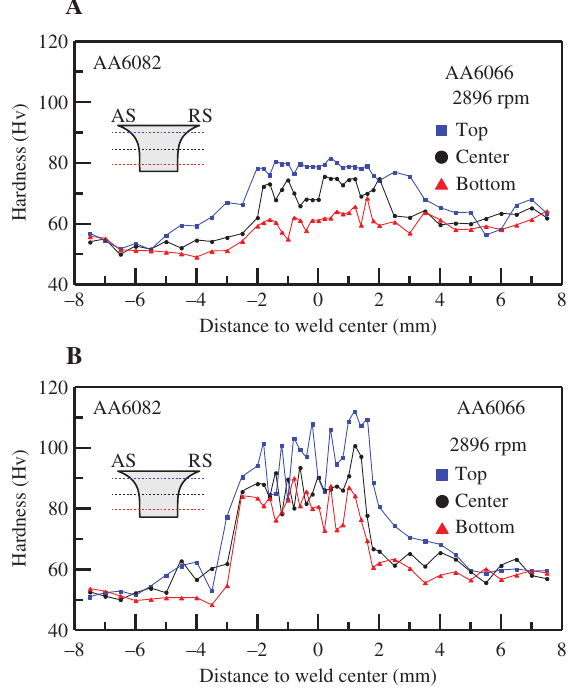
Figure 11: Microhardness profiles across the transverse cross section of welds at three different depths: (A) without reinforcing material and (B) with reinforcing material.